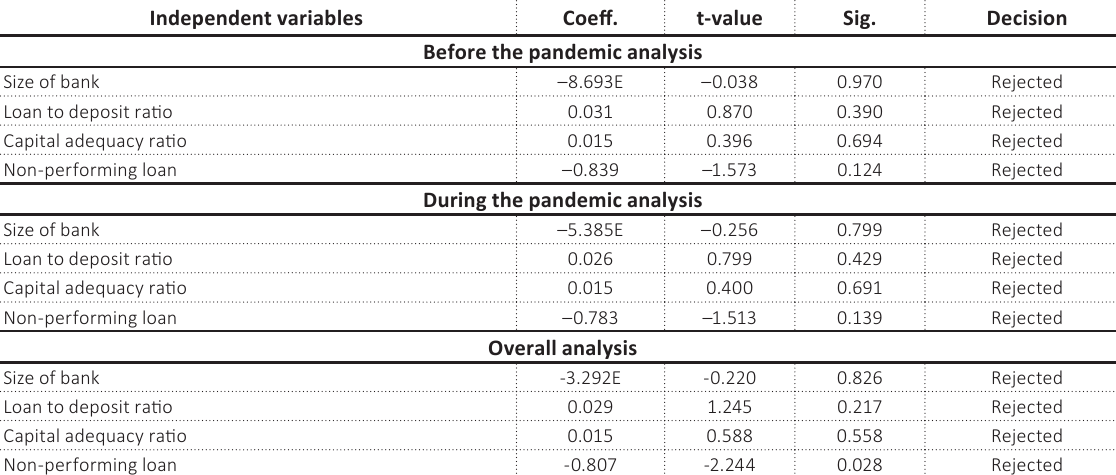
Table 4. Determinants of NIM before and during the